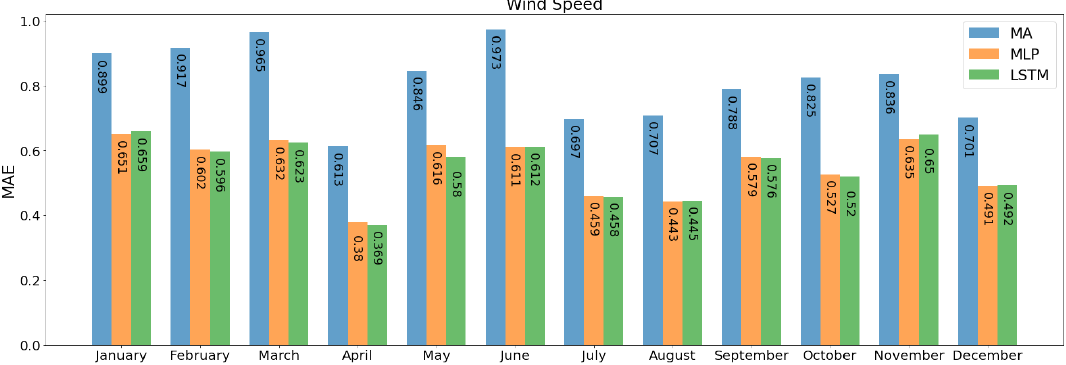
Figure 23. The performance metric (MAE) comparison for wind speed prediction for the whole year.